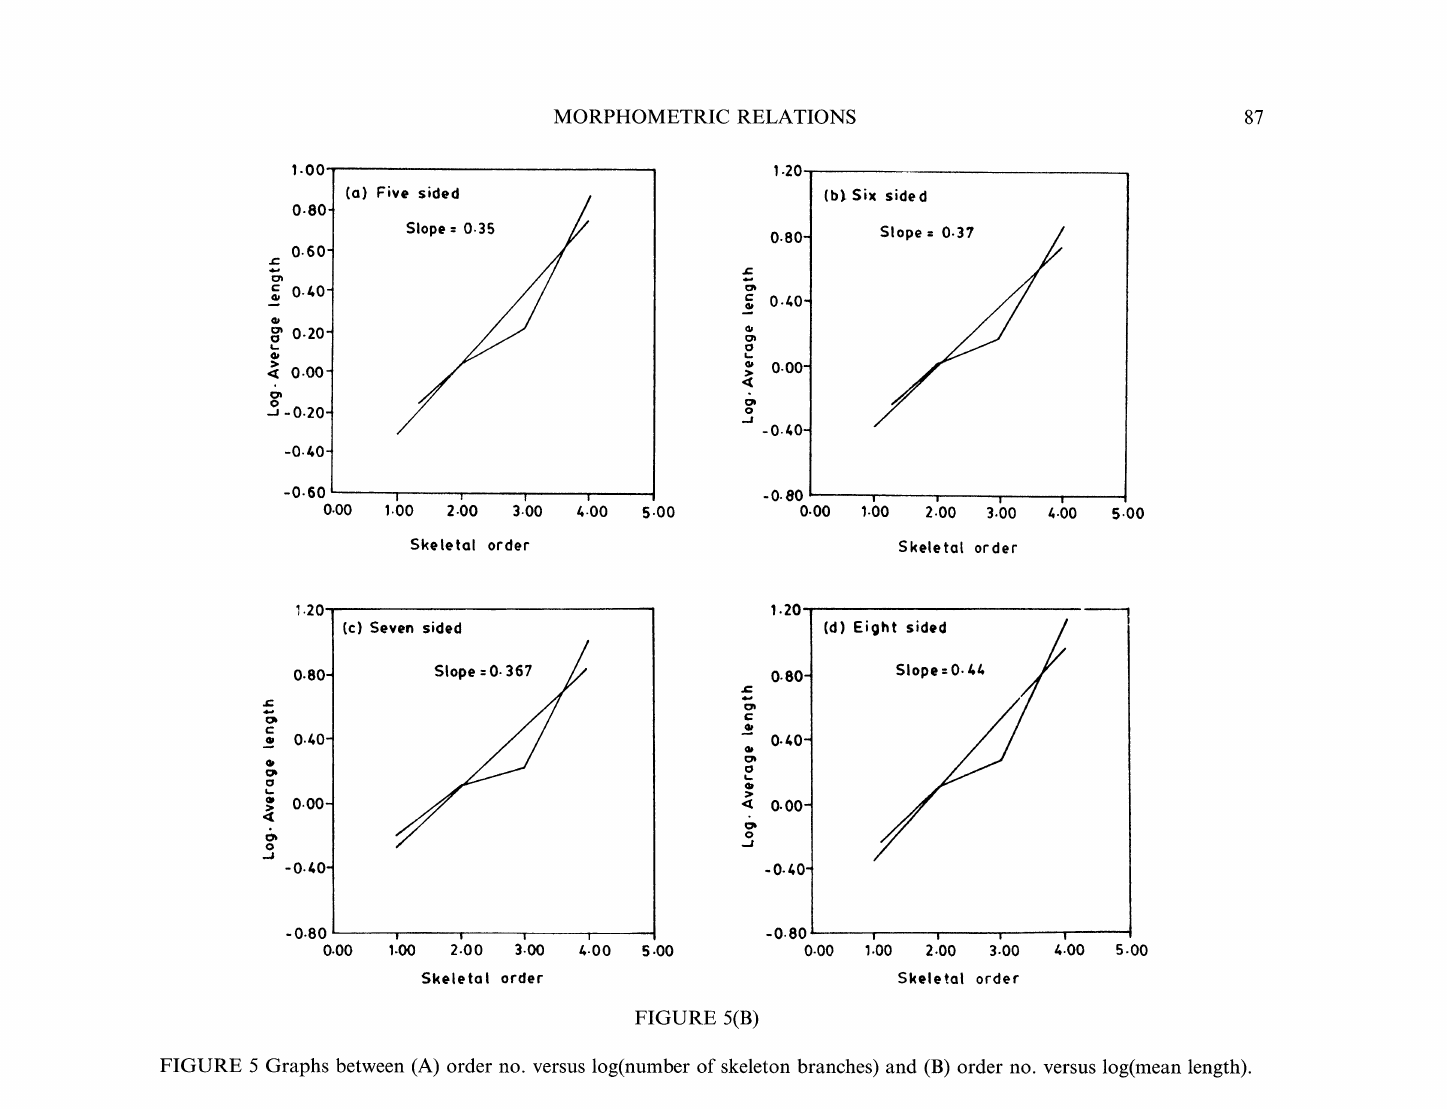
FIGURE 5 Graphs between (A) order no. versus log(number of skeleton branches) and (B) order no. versus log(mean length).